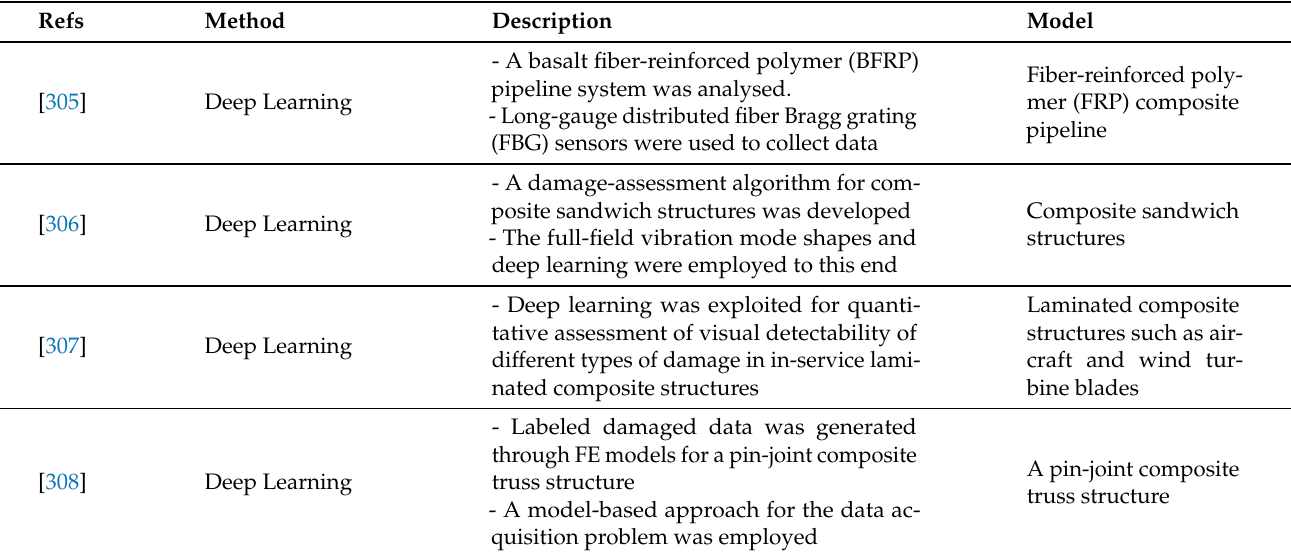
Table 19. Some review papers on the application of DL and ML in SHM of composite